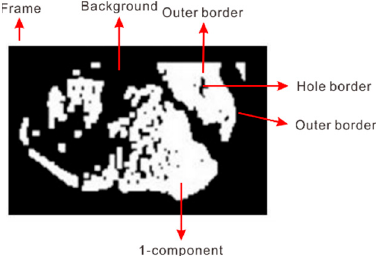
Figure 10. Connected components and borders.